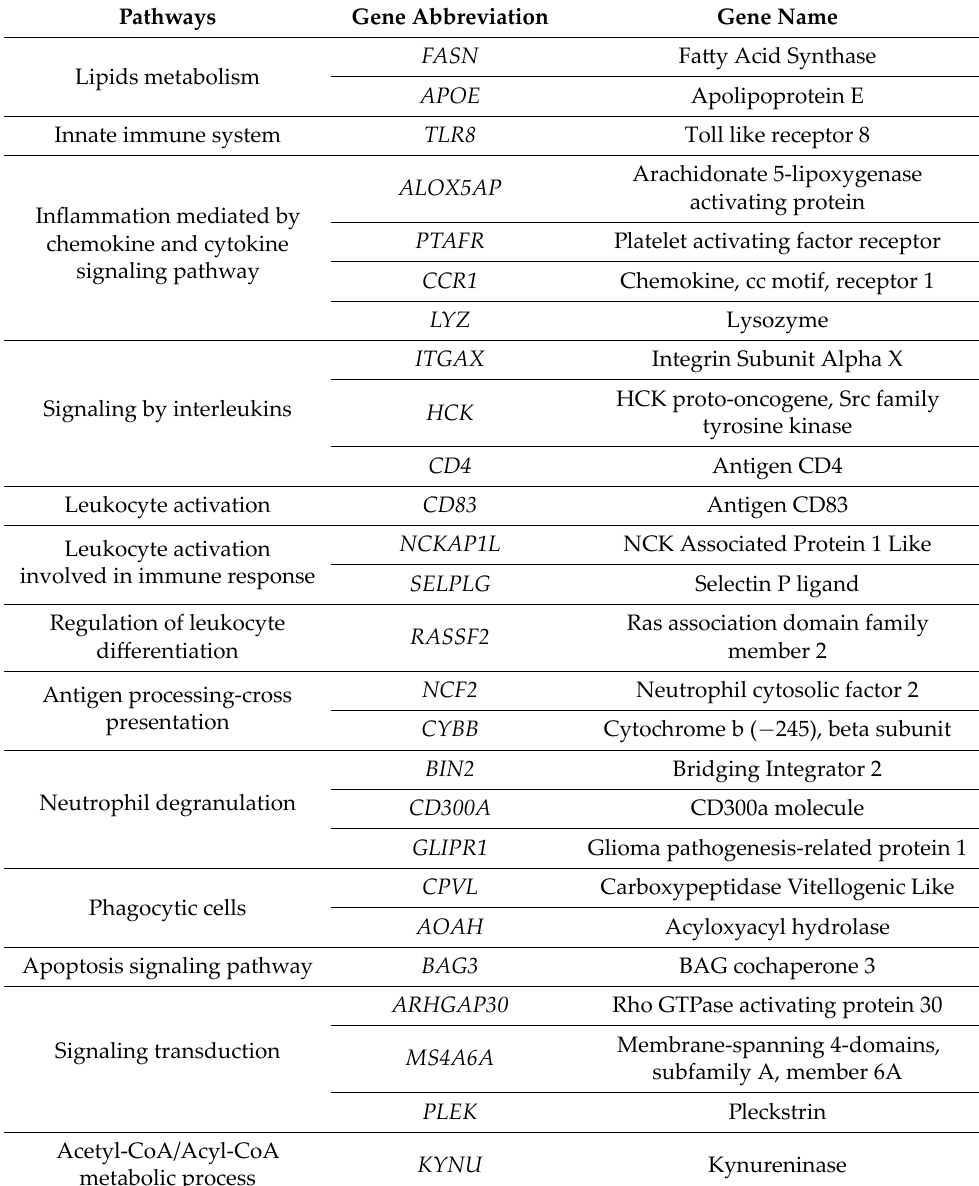
Table 2. Summary of transcriptomic genes differentially expressed in subcutaneous adipose tissue among lean, obese and